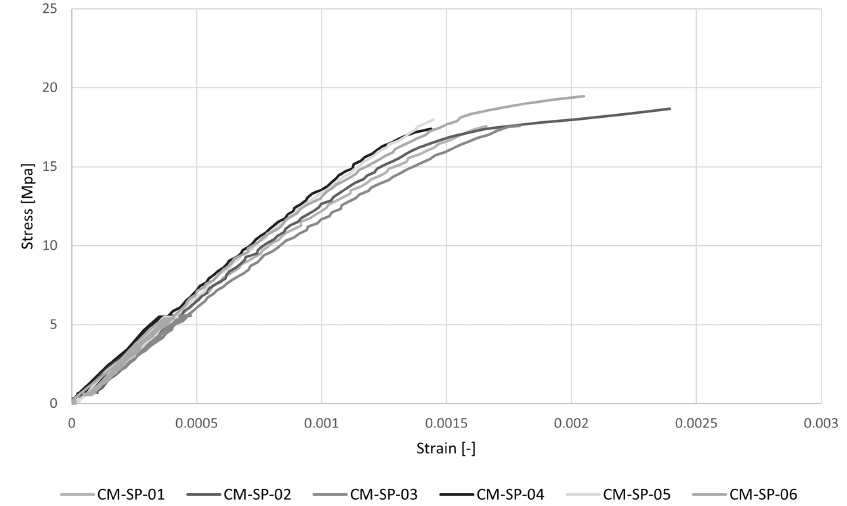
Figure 5. Stress–strain diagrams for uniaxial compression tests (CM-SP) for the determination of Young’s modulus in compression. Table 2. Results of uniaxial compression tests (CM-SP) for the determination of Young’s Modulus